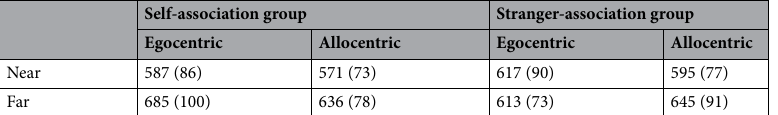
Table 1. Mean reaction times (ms) and standard deviations (ms) for all conditions between the self- association group and the stranger-association group.